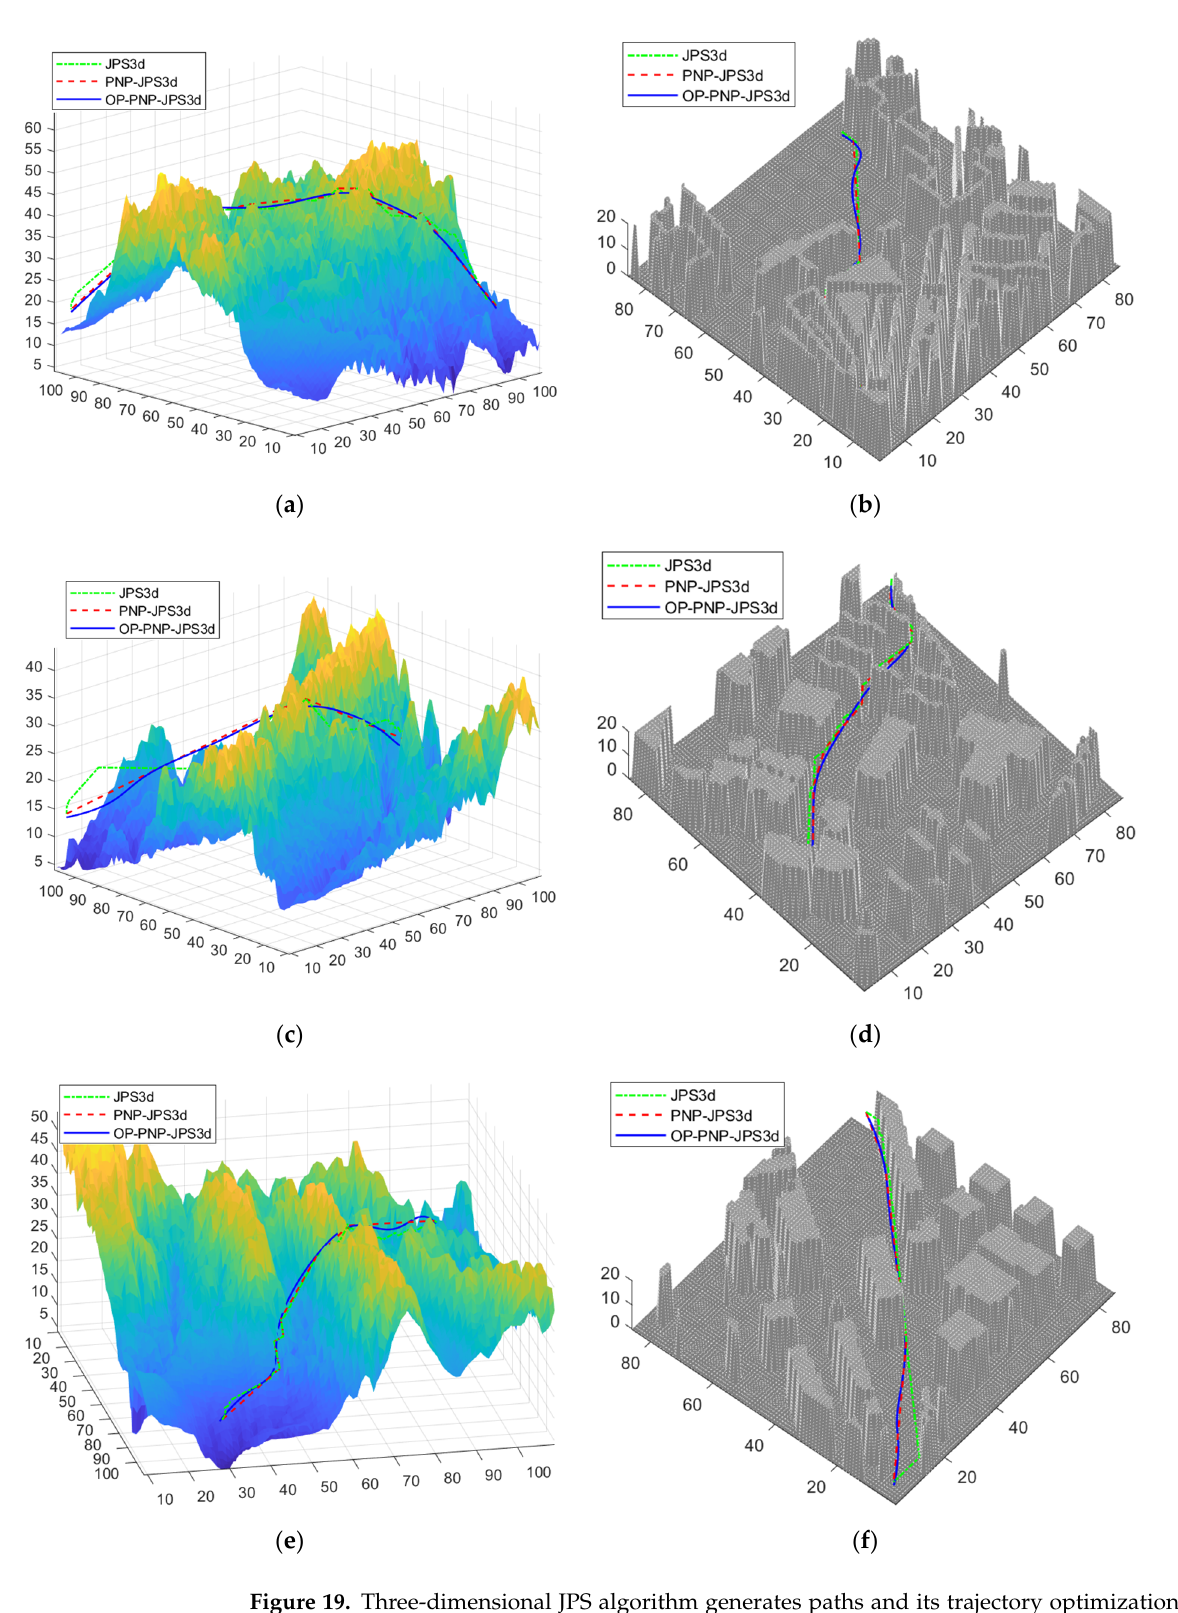
Figure 19. Three-dimensional JPS algorithm generates paths and its trajectory optimization path comparison experiment. ( a ) Map of the mountain region 1. ( b ) Map of London. ( c ) Map of the mountain region 2. ( d ) Map of New York. ( e ) Map of the mountain region 3. ( f ) Map of Boston.